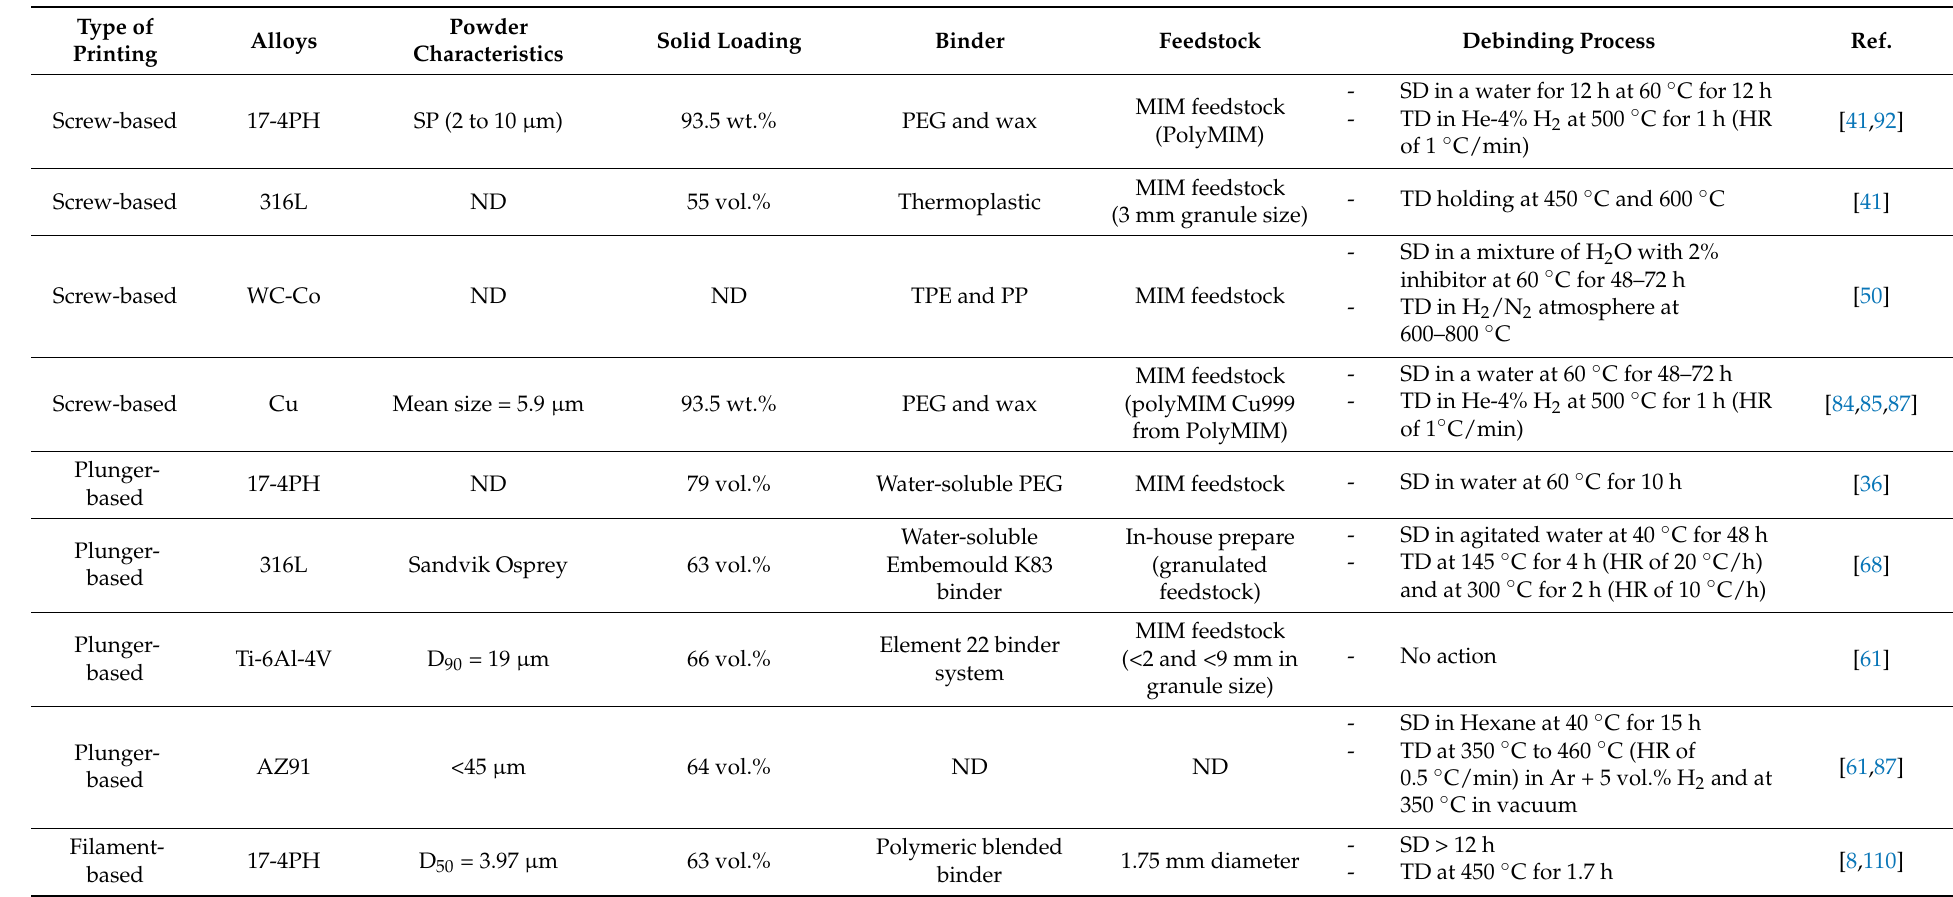
Table 3. Metal MEX feedstocks and debinding processes: alloys, powder characteristics, solid loading, binder and its debinding process, classified by feeding system (ND is no detail; SP is spherical powder; IP is irregular powder; SD is solvent debinding; TD is thermal debinding; HR is heating